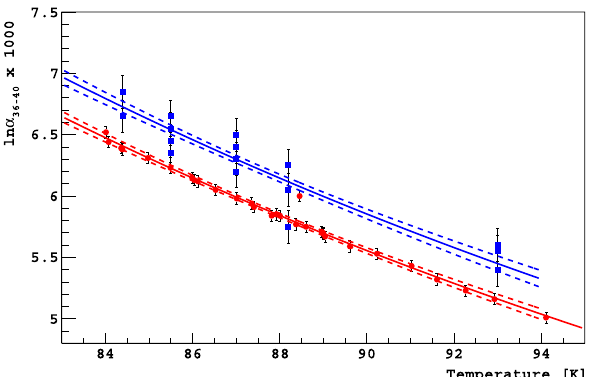
Fig. 21 Dependence of ln α 36 − 40 on temperature. The data points are taken from [21] (blue squares) and [22] (red dots). Fits with the function y = A · 1 / T 2 + B are overlaid. The continuous lines correspond to the mean values and the dashed lines to the 1 σ ln ˆ α deviations. The errors on the single measurement were set all equal in the fit and determined in retrospect requiring the reduced χ 2 to be 1